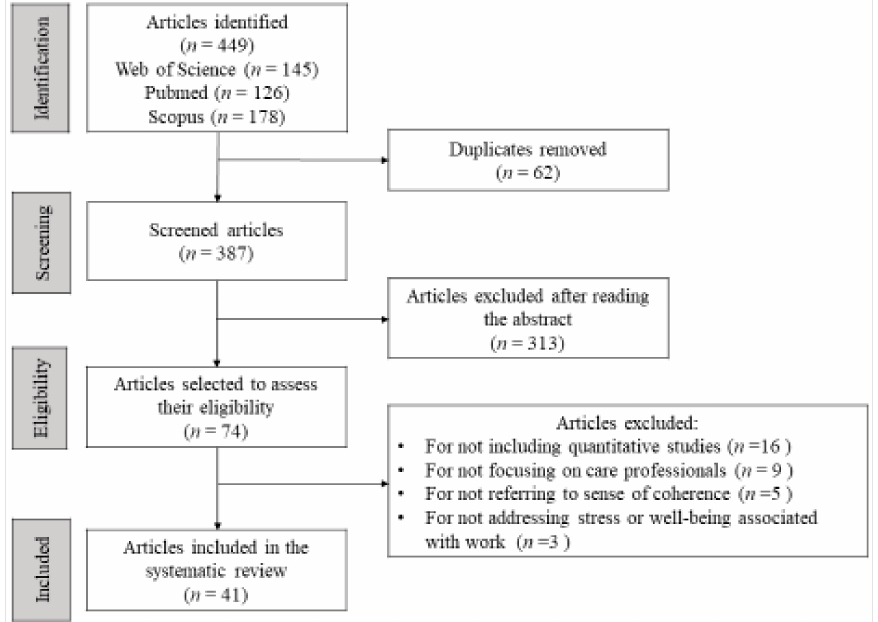
Figure 1. PRISMA